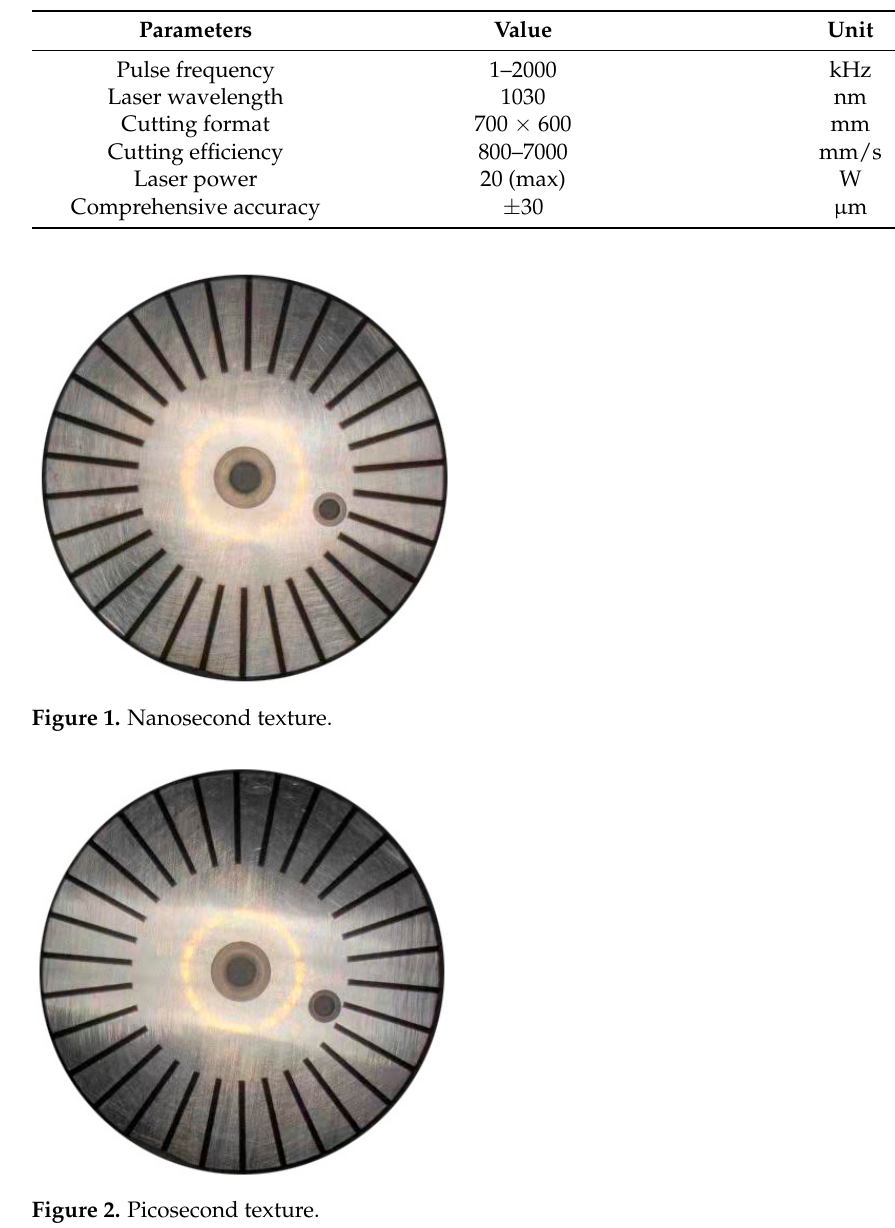
Table 2. Specific parameters of picosecond laser equipment.